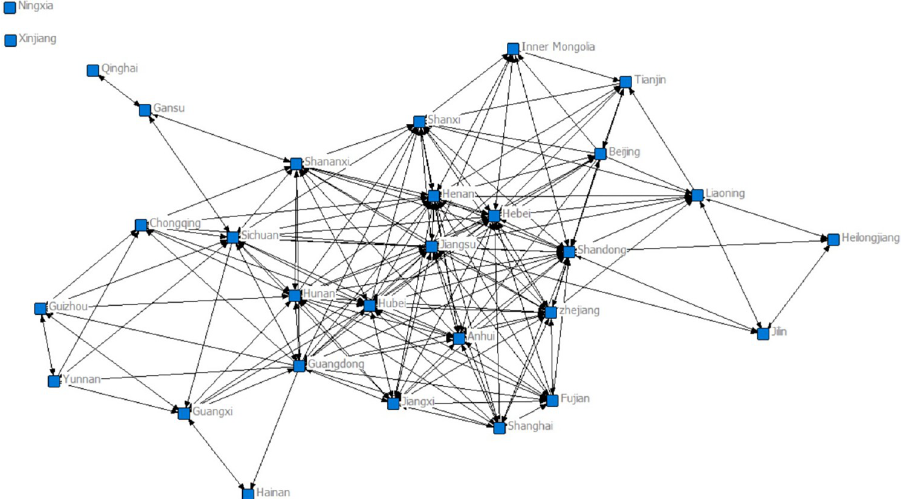
Fig 7. Topology of the 30-city converged network in